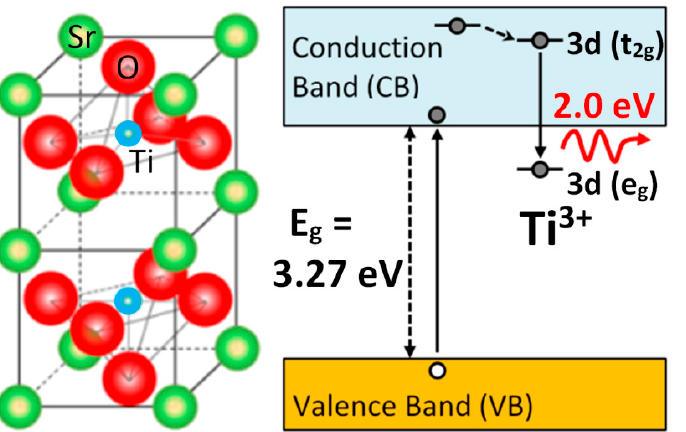
Figure 7. Schematics of the structure and electronic levels for the oxygen vacancy centers in SrTiO 3 . Possible mechanisms of the electronic processes involving the electron polaron (Ti 3+ ) trapped adjacent to oxygen vacancies. The transition inside the TiO 6 octahedron involving the excited (t 2g ) and ground (e g ) levels gives rise to the 2.0 eV red luminescence band. This figure has been adapted from Crespillo et al. [25], Copyright (2018), with permission of Elsevier.